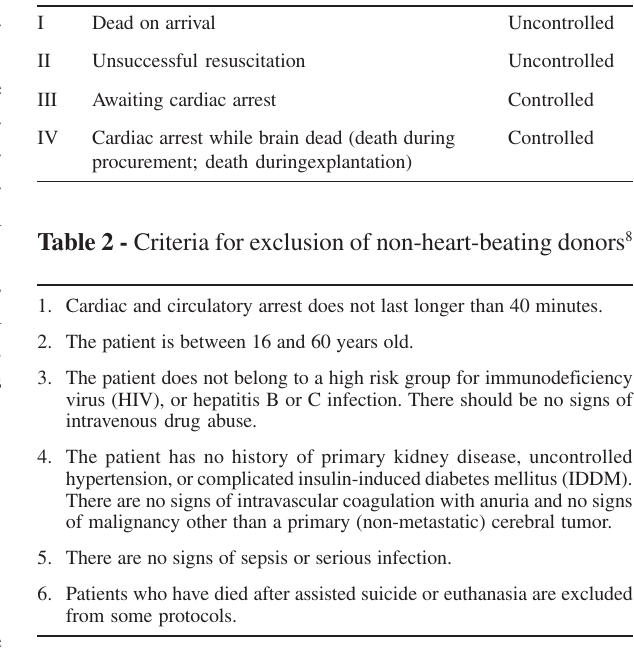
Table 3 - Criteria for brainstem death apply to heart-beating